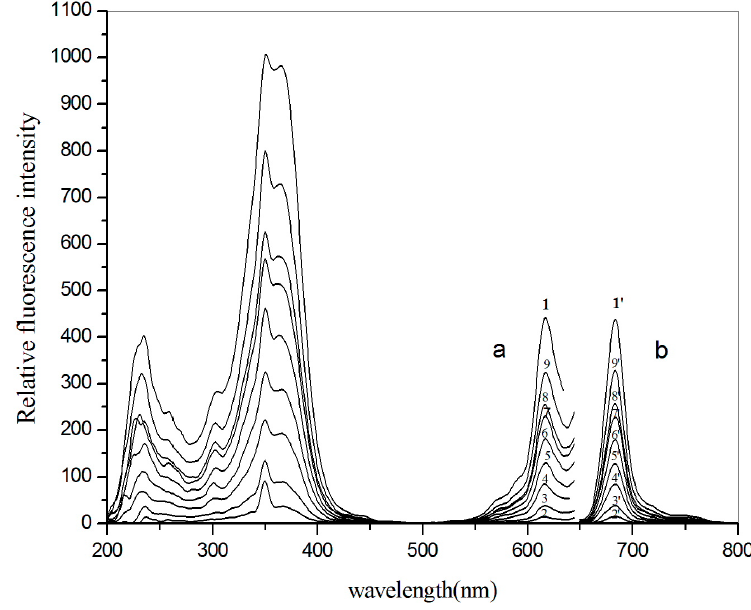
Figure 3. Excitation ( a ) and emission ( b ) of AlS 4 P C -Alcian blue 8GX in the presence of Hg(II) in an aqueous medium with a pH of 5.0. 1-1’. Buffer + AlS 4 Pc, [AlS 4 Pc] = 1.0 × 10 − 6 mol/L, [EDTANa 2 ] = 1.0 × 10 − 4 mol/L. 2-2’. Buffer + AlS 4 Pc + Alcian blue 8GX, [AlS 4 Pc] = 1.0 × 10 − 6 mol/L, [Alcian blue 8GX] = 1.50 × 10 − 6 mol/L, [EDTANa 2 ] = 1.0 × 10 − 4 mol/L; 3-3’, 4-4’, 5-5’, 6-6’, 7-7’, 8-8’, 9-9’. Buffer + AlS 4 Pc + Alcian blue 8GX + Hg(II), [AlS 4 Pc] = 1.0 × 10 − 6 mol/L, [Alcian blue 8GX] = 1.50 × 10 − 6 mol/L, [EDTANa 2 ] = 1.0 × 10 − 4 mol/L, concentrations of Hg(II) for curves 3–9 and 3’–9’: 0.2, 0.4, 2.0, 10.0, 50.0, 100.0 and 200.0 µmol/L, respectively.